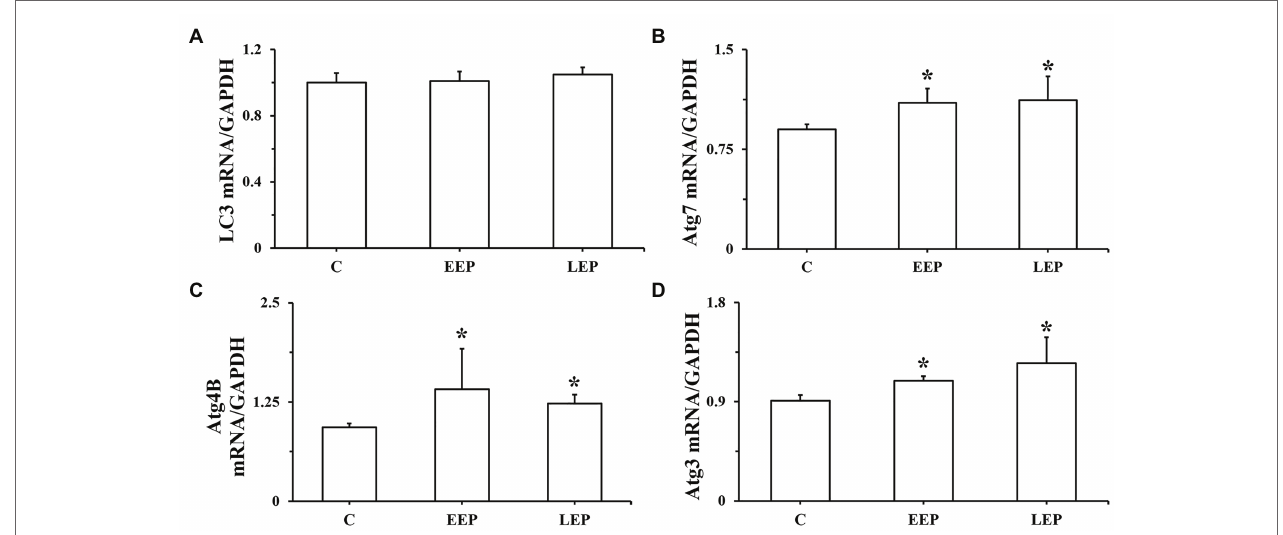
FIGURE 6 | Expression of LC3, Atg7, Atg4B, and Atg3 mRNA during EP. (A) LC3 mRNA levels, (B) Atg7 mRNA levels, (C) Atg4B mRNA levels, and (D) Atg3 mRNA levels were determined by real-time PCR (RT-PCR). * p < 0.05 vs. group